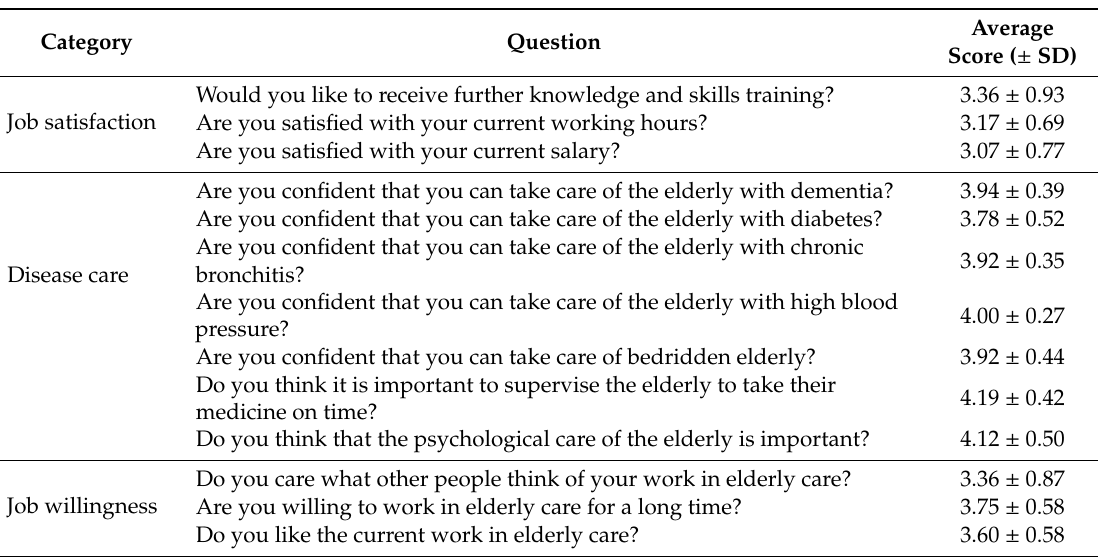
Table 3. Respondents’ attitude on elderly care.